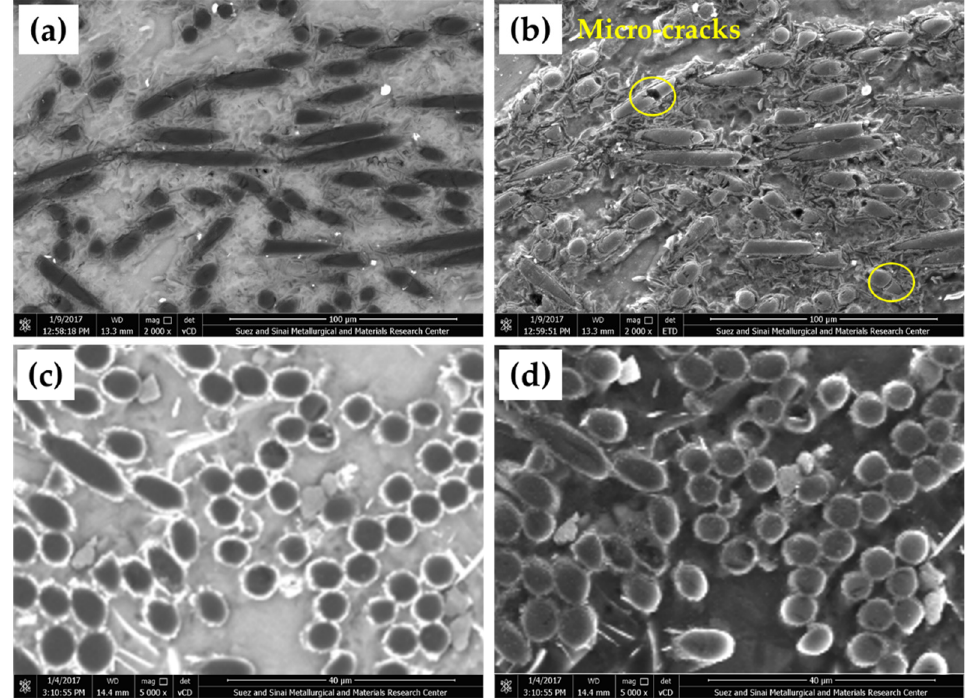
Figure 4. SEM images show the microstructures of Composite-N, ( a ) VCD, ( b ) EDT and Composite-P, ( c ) VCD, and ( d ) EDT.